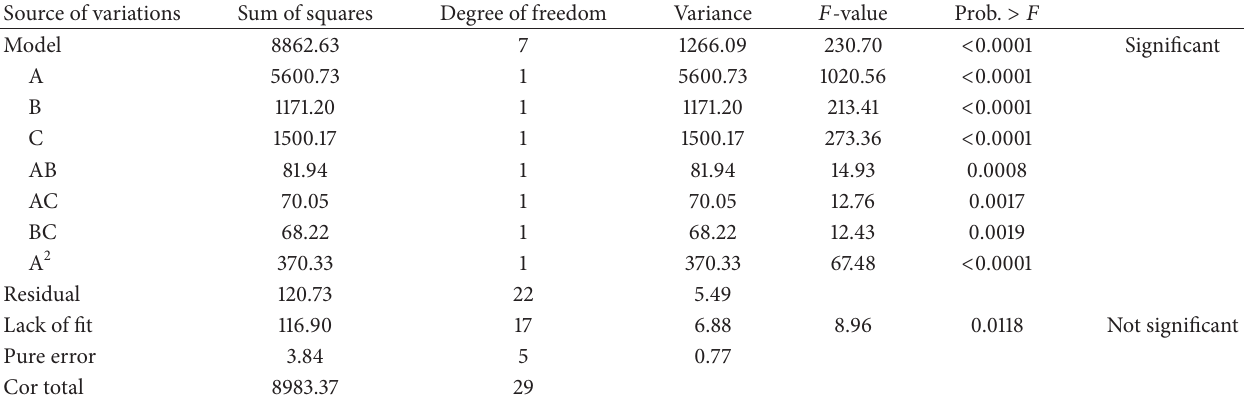
Table 5: Analysis of variance (ANOVA) for fit of removal efficiency from central composite